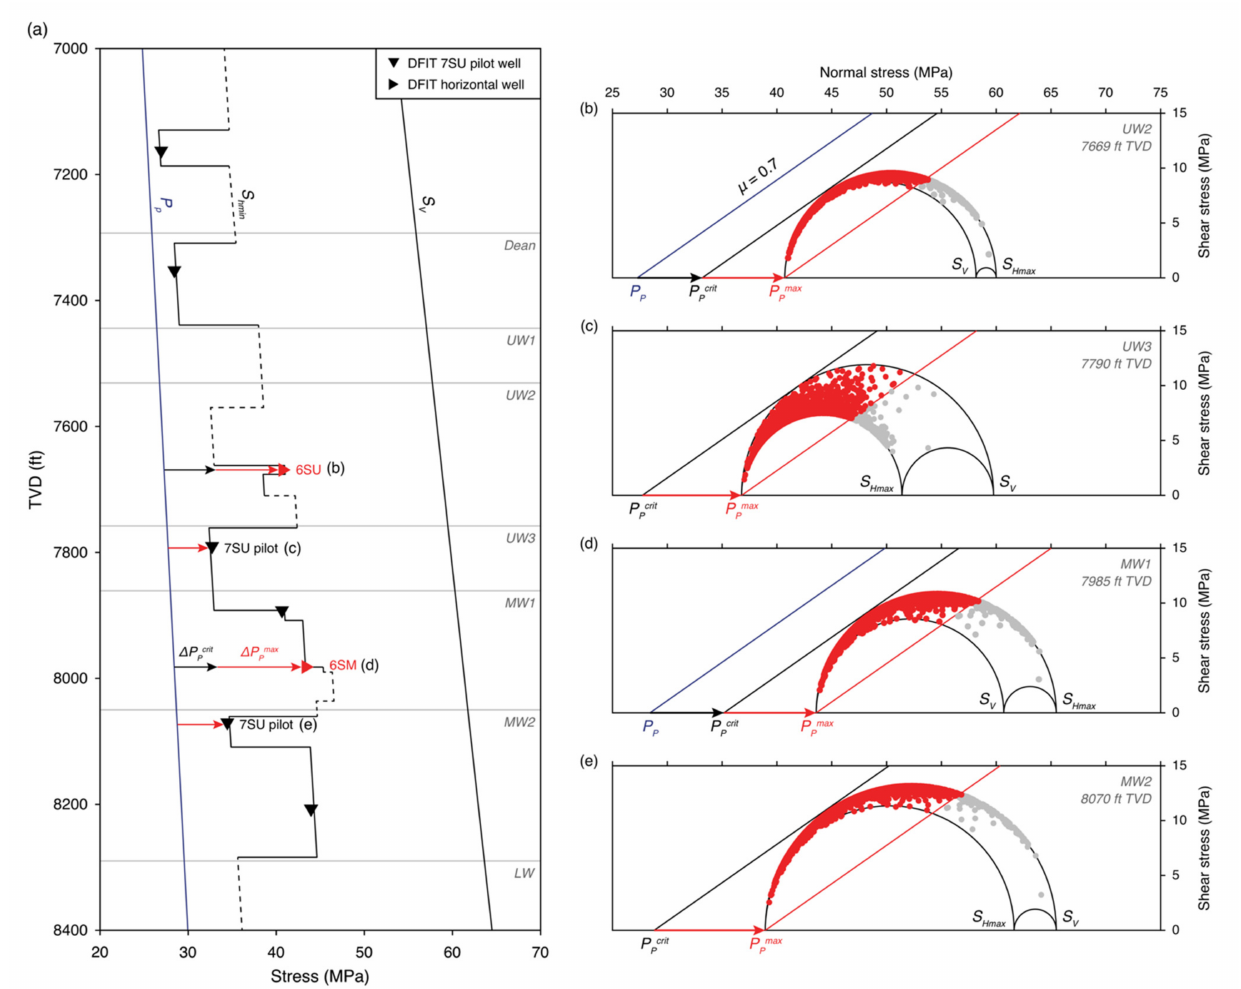
Figure 8. ( a ) Interpreted stress profile based on stratigraphically shifted stress measurements. ( b – e ) Mohr circle diagrams for stress layers in the Upper and Middle Wolfcamp. In each diagram, the fractures that are plotted represent the sum of observations from image logs (wells 6SU, 6SM, and 7SU) and from core samples from slant core well 6TW. Red points represent the population of fractures that are activated if pore pressure is raised to the value of S hmin . P Pcrit is the pressure needed to active faults given a coefficient friction of 0.7 and P Pmax is the maximum possible pressure, i.e., S hmin